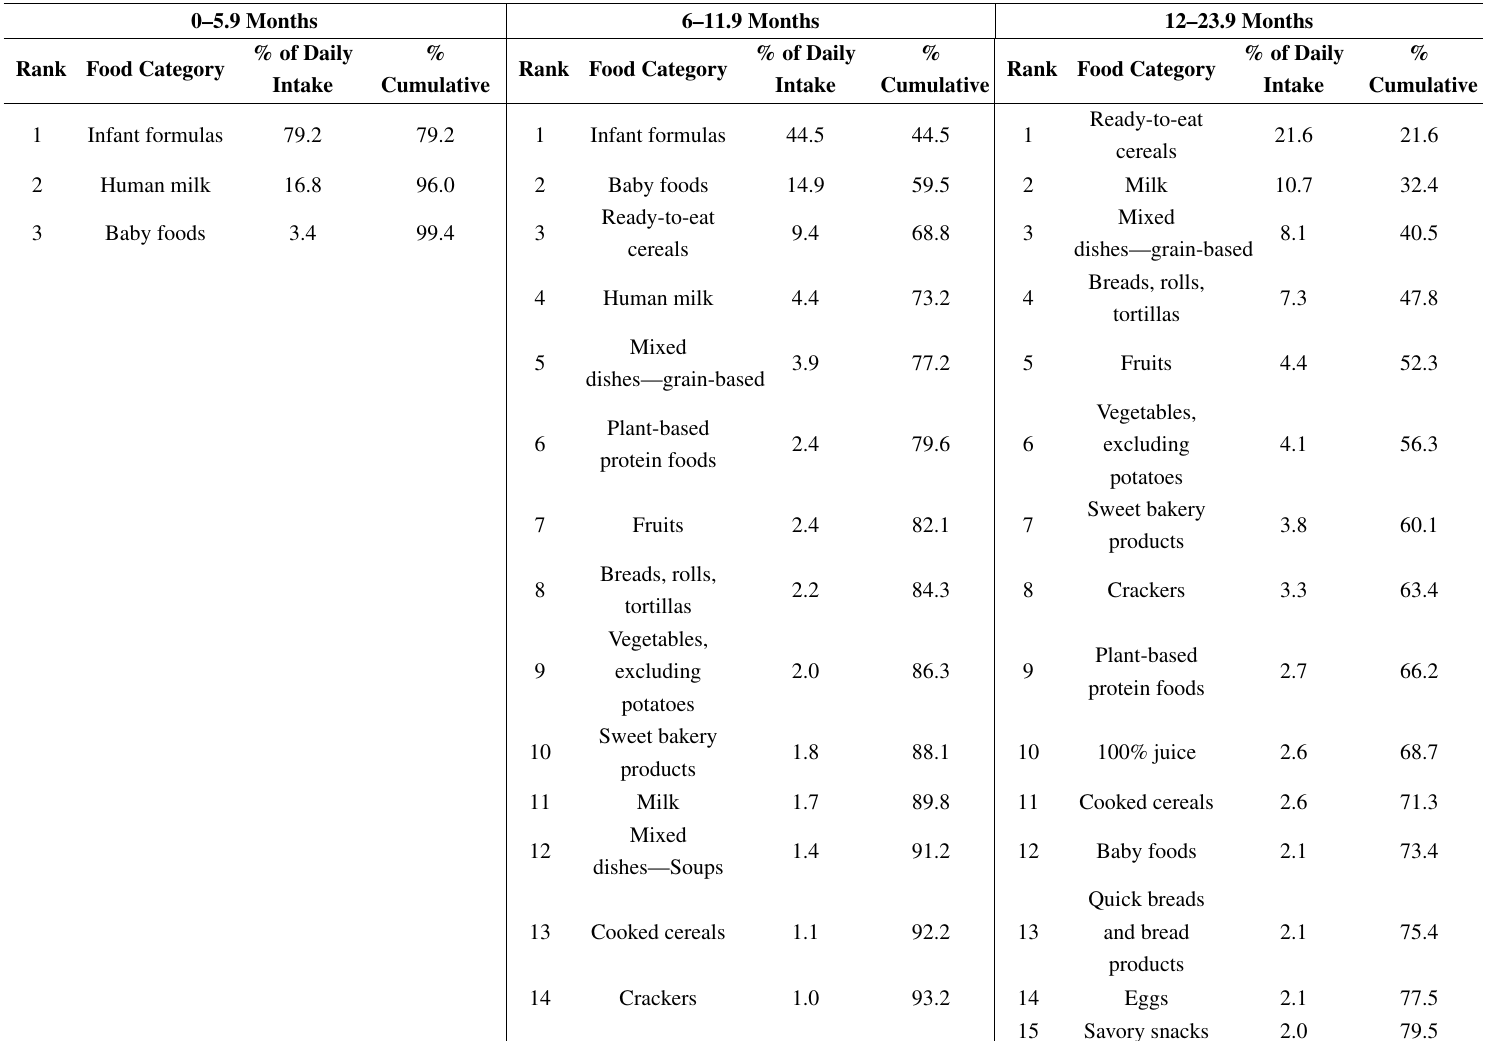
Table 10. Food sources of folate (includes fortified (folic acid in foods) and folate) among US infants and toddlers aged 0–23.9 months by age group: NHANES 2005–2012 ( n = 2740) a